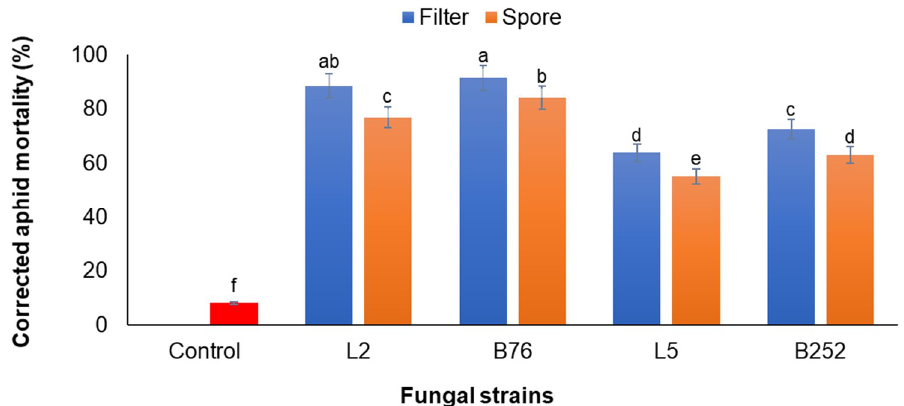
Figure 3. Comparison of the mortality of M. japonica by filtrate and the conidia from different fungal strains ( V. lecanii and B. bassiana ). Columns show the mortality of aphids by different fungal strains ± SE ( n = 50). The different letters express the significant difference between different treatments (one‐ way factorial analysis of variance (ANOVA); least significant difference (LSD) test at α = 0.05). Table 3. Analysis of variance (ANOVA) for the comparison of the mortality of M. japonica by filtrate and the conidia from different fungal strains ( V. lecanii and B. bassiana ).